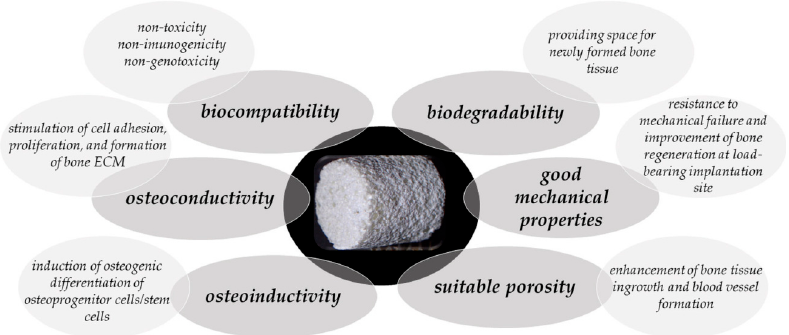
Figure 1. Scheme presenting main properties of tissue-engineered products as an alternative solution for bone regenerative medicine.